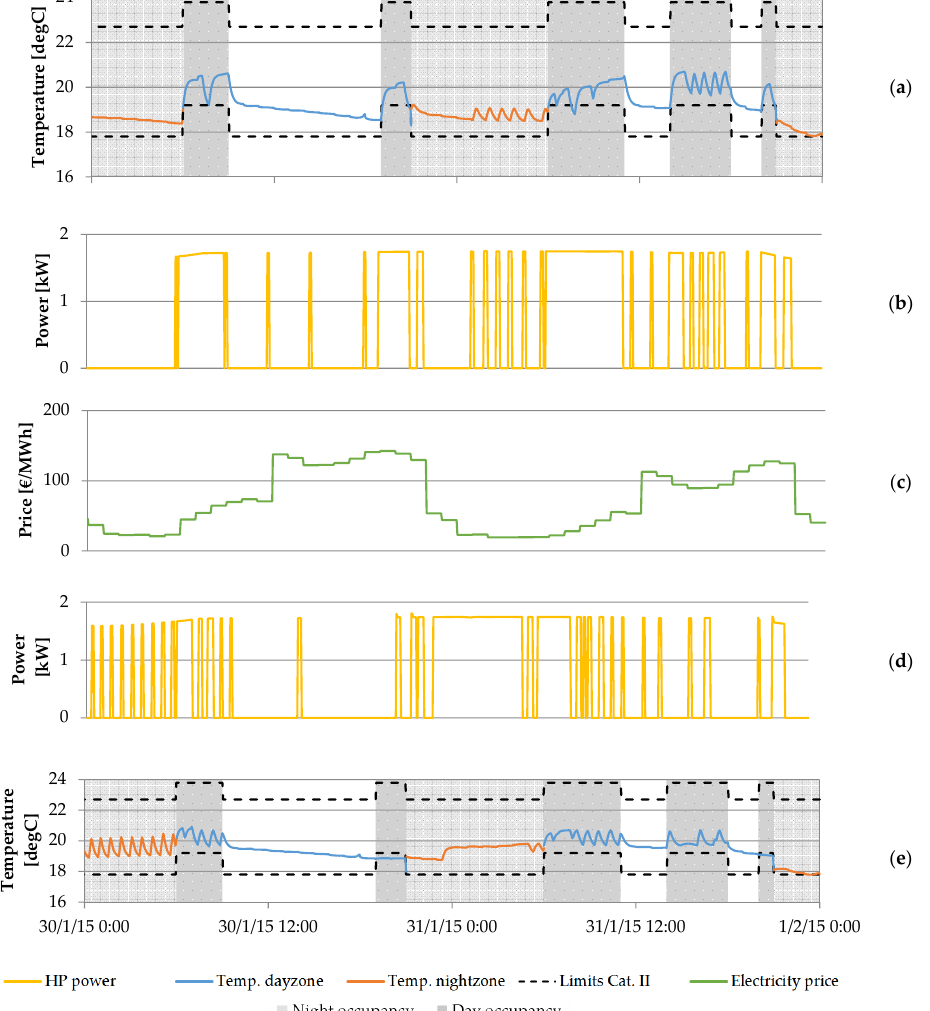
Figure 5. Example of results in the form of time series for two selected days. Graphs ( a , b ) respectively present the indoor temperature and the heat pump power for Case 4 (reference); Graph ( c ) shows the common electricity price for Cases 4 and 6 for 30 January 2015 and 31 January 2015 (two-periods tariff); Graphs ( d , e ) respectively present the heat pump power and the indoor temperature for Case 6 (flexibility case); In Graphs ( a , e ), the temperature curve is shown according to the occupancy; when the occupants are present in the dayzone (dark grey areas), the temperature of the living room is shown (in blue), while, when they occupy the nightzone (light gray areas), the temperature of one bedroom is shown (in orange). When the occupants are not present (white background), the temperature of the living room is shown.